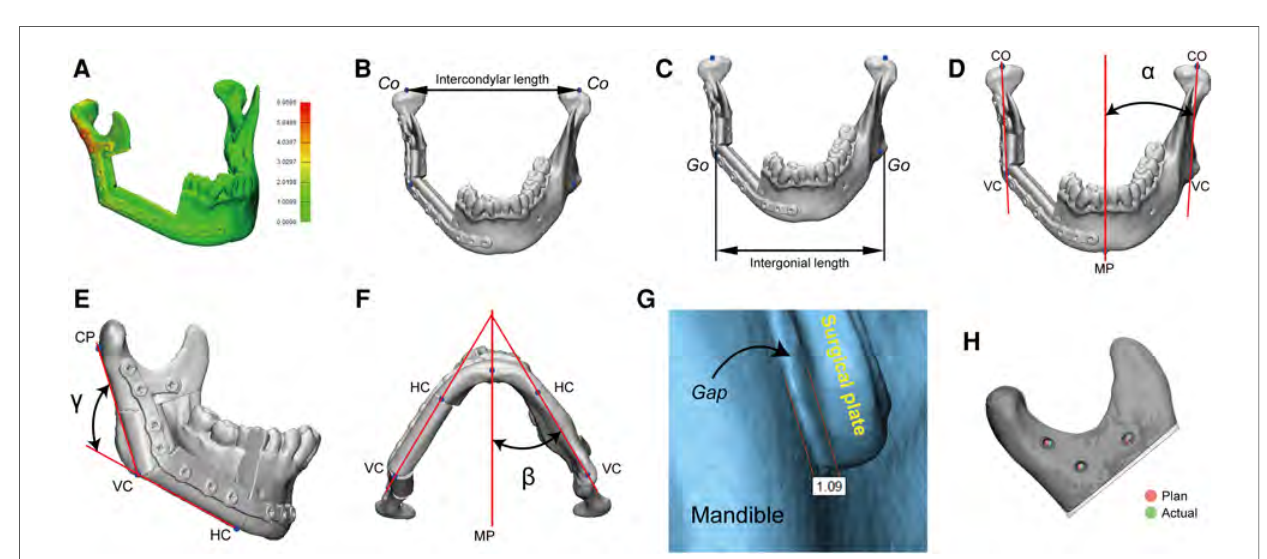
FIGURE 5 A panel of measurements for surgical precision. Co, condylion; Go, gonion; VC, vertical corner; MP, midsagittal plane; HC, horizontal corner; CP, condylion posterior; α , coronal mandibular angle; β , axial mandibular angle; γ , sagittal mandibular